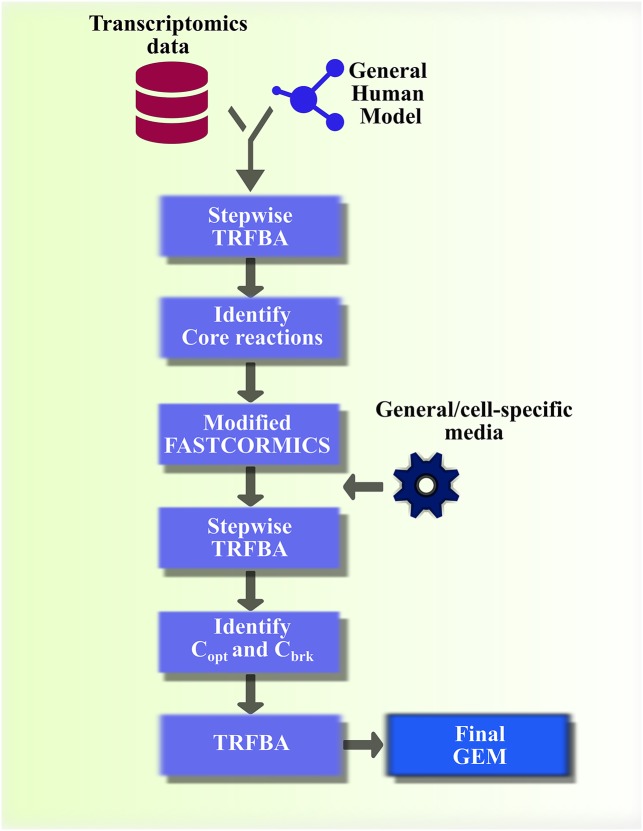
TRFBA-CORE workflow.TRFBA-CORE employs the stepwise version of TRFBA to identify a set of growth-associated reactions, build cell-specific models using modified FASTCORMICS, and generate tuned cell-specific GEMs.